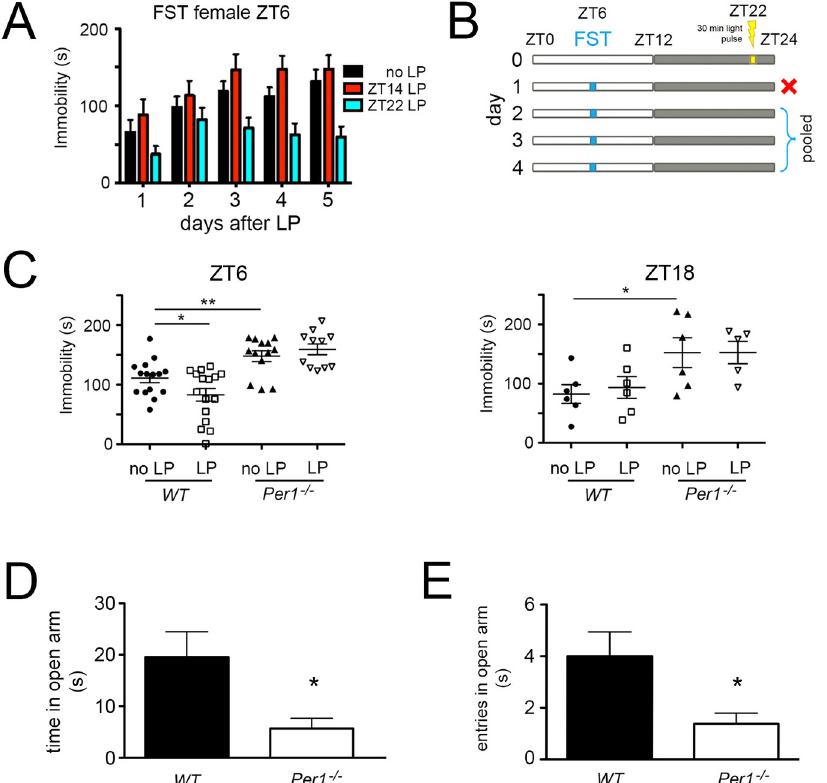
Fig 1. Light at ZT22 affects despair-based behavior. (A) Immobility time in the forced swim test (FST) of wild type female mice assessed over several days at ZT6 after no light pulse (LP) (black bars), after a LP at ZT14 (red bars), and after a LP at ZT22 (blue bars). Two-way repeated measures ANOVA (n = 13–15), ZT14 LP p = 0.255, ZT22 LP p = 0.014, values are means ± SEM (B) Light pulse treatment and assessment protocol using the FST. The first day after the light pulse the FST was performed but only the data from days 2–4 were pooled and used for further analysis. (C) Immobility time of wild type and Per1 -/- female mice with and without LP at ZT22 assessed at ZT6 (left panel, n = 11– 16) or ZT18 (right panel, n = 5–6). Unpaired t-test, � p < 0.05, �� p < 0.01, values are means ± SEM. (D) Time spent in the open parts of an O-maze. Unpaired t-test, n = 8 for each genotype, � p < 0.05, values are means ± SEM. (E) Entries into the open parts of an O-maze. Unpaired t-test, n = 8 for each genotype, � p < 0.05, values are means ± SEM. (12:12 LD) cycle. The light pulse was applied in the dark phase at zeitgeber time (ZT) 14 or 22, with ZT0 being lights on and ZT12 lights off. The mice were then subjected to a forced swim test (FST) at ZT6 for the next five days where their immobility time was assessed (Figs 1A and S1A). Animals that received no light pulse (black bars) or a light pulse at ZT14 (red bars) showed comparable immobility times (Figs 1A and S1A). In contrast, mice that received a light pulse at ZT22 (blue bars) displayed lower immobility times compared to control animals. This difference was statistically significant in females (Fig 1A), but only showed a similar trend in males (S1A Fig), which is consistent with previous findings in rats [17]. Based on these data we performed the subsequent experiments with female mice and applied a light pulse only at ZT22. The FST was performed at ZT6 and immobility time was assessed for the four following days. The data of days 2–4 were pooled to compare immobility times between animals (Fig 1B). Consistent with the results in Fig 1A wild type mice showed reduced immobility time at ZT6 when they received a light pulse at ZT22 (Fig 1C, left panel), but not when they were assessed at ZT18 (Fig 1C, right panel). Since Per1 is a light-inducible gene in the SCN [9,10], we tested mice lacking this gene in the same paradigm. At ZT6, as well